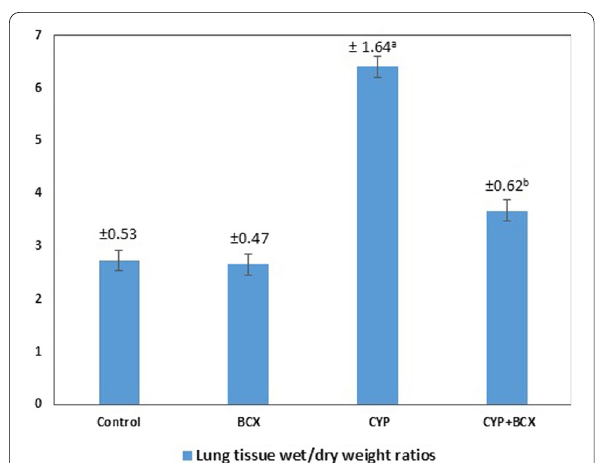
Fig. 1 Lung tissue wet/dry weight ratios in the studied groups tested by using Student’s t test. a P < 0.05 is significant in group III versus group I and b P < 0.05 is significant in group IV versus group